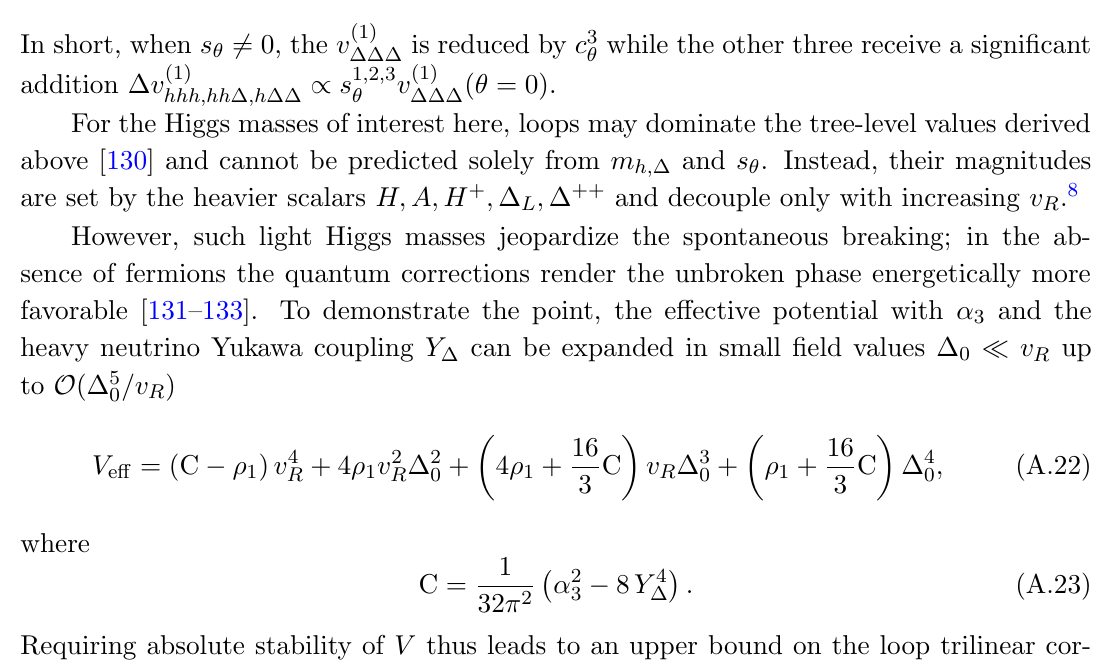
with (cid:12)xed R